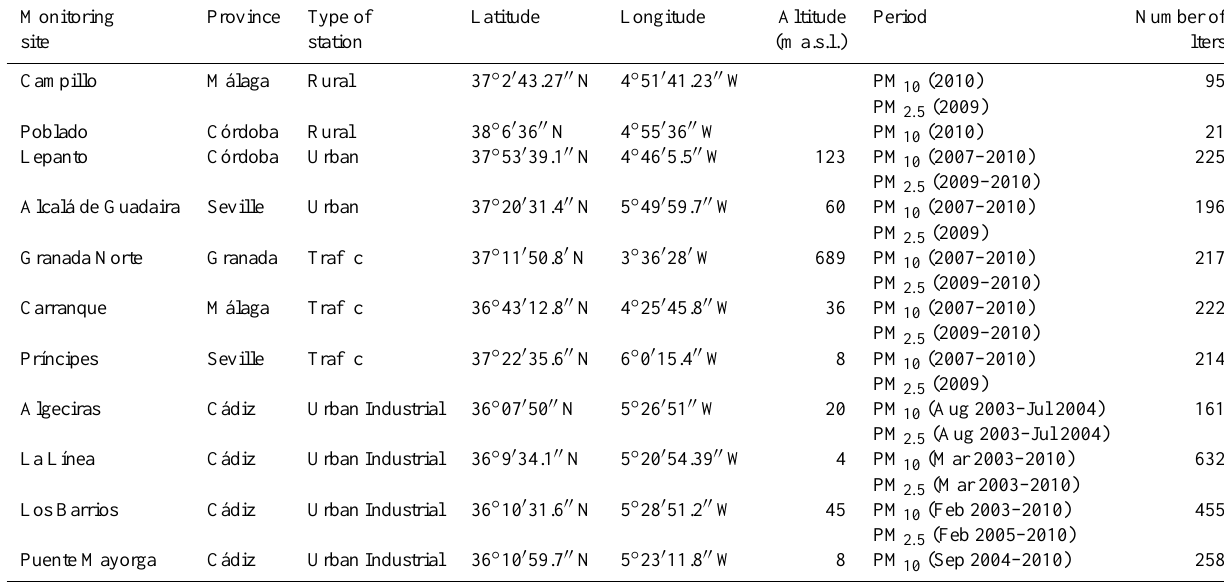
Table 1. Details of PM monitoring sites and sampling periods.